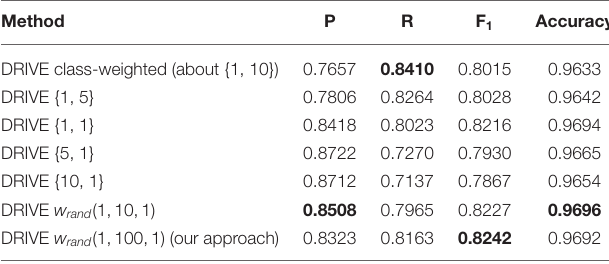
TABLE 8 | Results of different combination of fixed weights in cross entropy loss function without targeted prediction for DRIVE dataset { w 0 , w 1 }={weight for class 0 or background pixels, and weight for class 1 or vessel